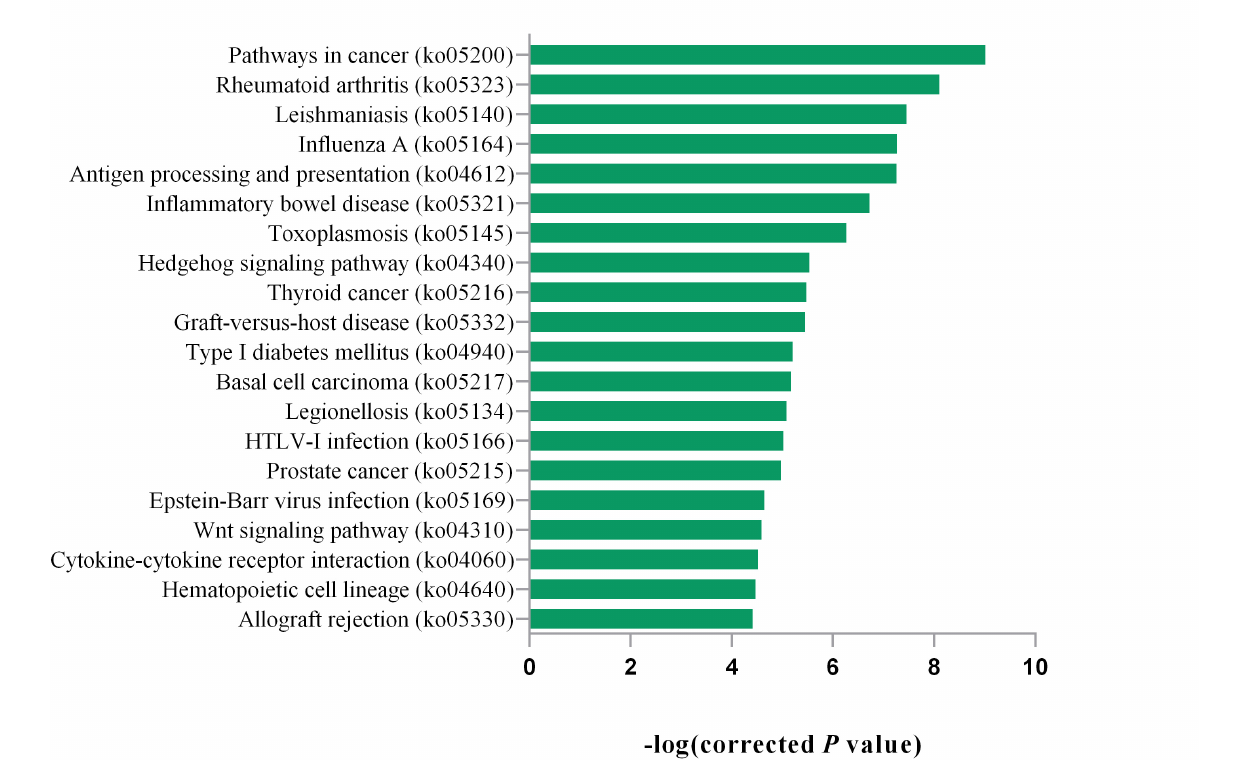
FIGURE 3 | The top 20 significantly enriched pathway terms for DEGs. The top 20 KEGG pathway terms are Pathways in cancer (ko05200), Rheumatoid arthritis (ko05323), Leishmaniasis (ko05140), Influenza A (ko05164),Influenza A (ko05164), Antigen processing and presentation (ko04612), Inflammatory bowel disease (ko05321), Toxoplasmosis (ko05145), Hedgehog signaling pathway (ko04340), Thyroid cancer (ko05216), Graft-versus-host disease (ko05332), Type I diabetes mellitus (ko04940), Basal cell carcinoma (ko05217), Legionellosis (ko05134), HTLV-I infection (ko05166), Prostate cancer (ko05215), Epstein-Barr virus infection (ko05169), Wnt signaling pathway (ko04310), Cytokine-cytokine receptor interaction (ko04060), Hematopoietic cell lineage (ko04640), Allograft rejection